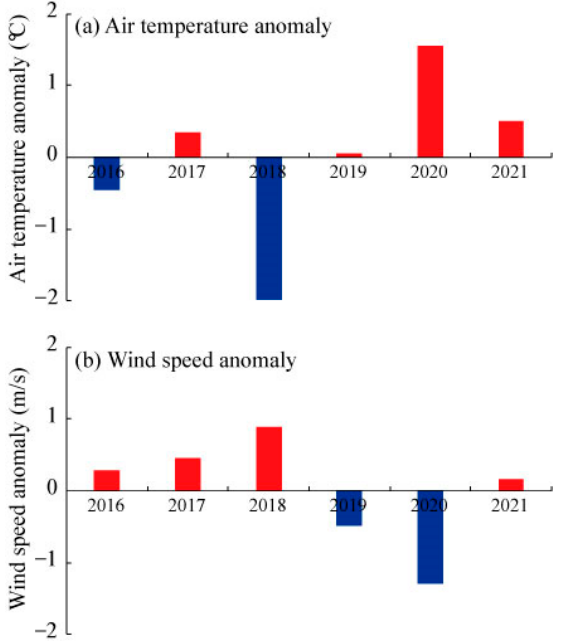
Figure 10. Inter-annual changes in ( a ) air temperature and ( b ) wind speed anomalies in the western part of East/Japan Sea.